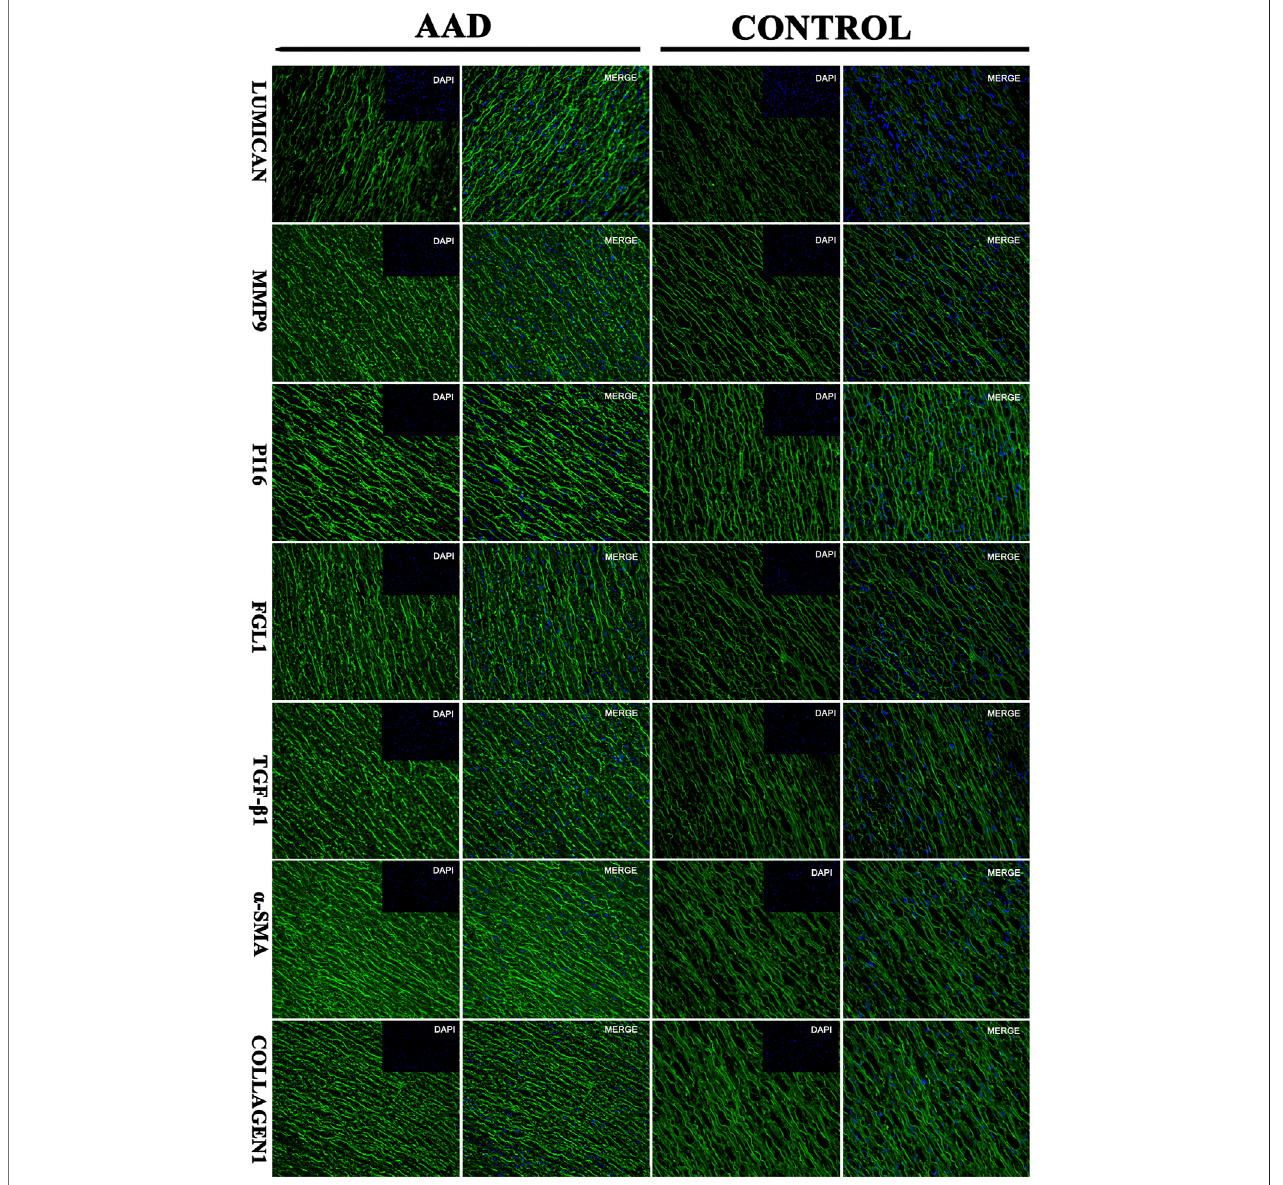
FIGURE 7 | Immuno fl uorescence: the target protein of the aortic dissection group and the control group (Lumican, matrix metalloproteinase-9 (MMP9), peptidase inhibitor 16 (PI16, peptidase inhibitor 16), fi brinogen-like protein 1 (FGL1, fi brinogen-like protein 1).